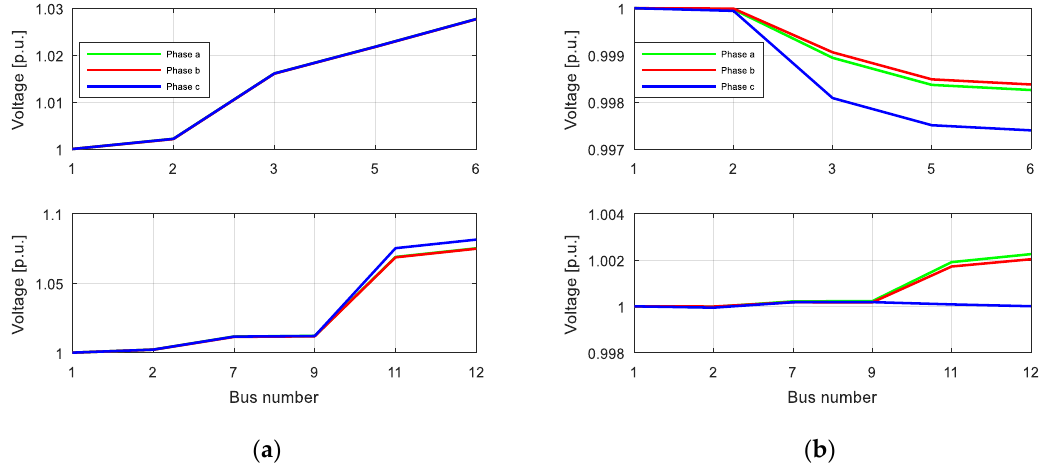
Figure 13. Scenario 3: Bus voltage profiles for branches B1 (up) and B2 (down) at the hours: ( a ) Peak-H and ( b ) Peak-L.